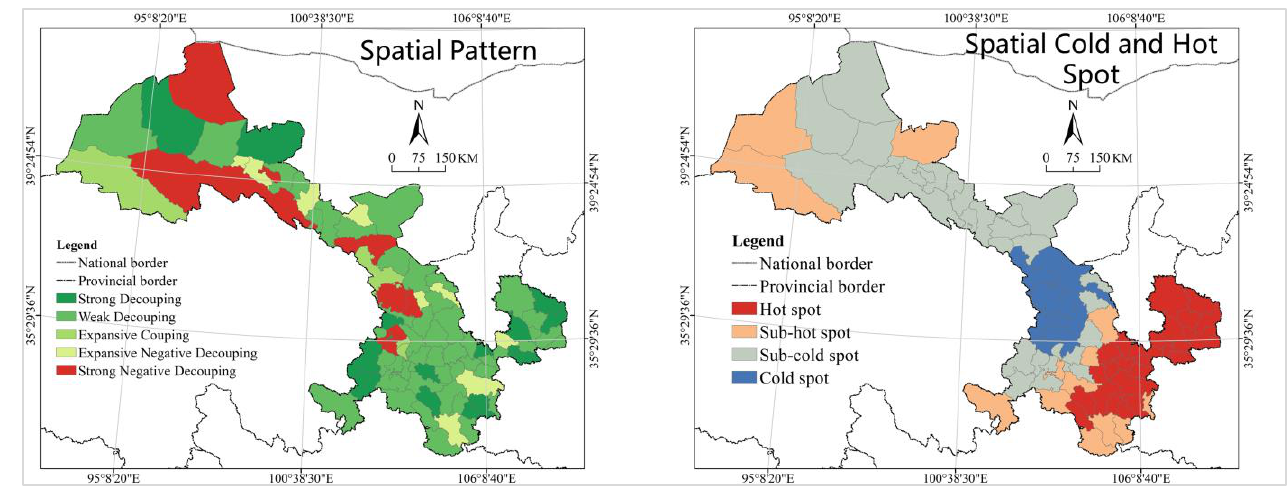
Figure 12. Spatial analysis on the decoupling relationship between urban construction land and urban population in Gansu.